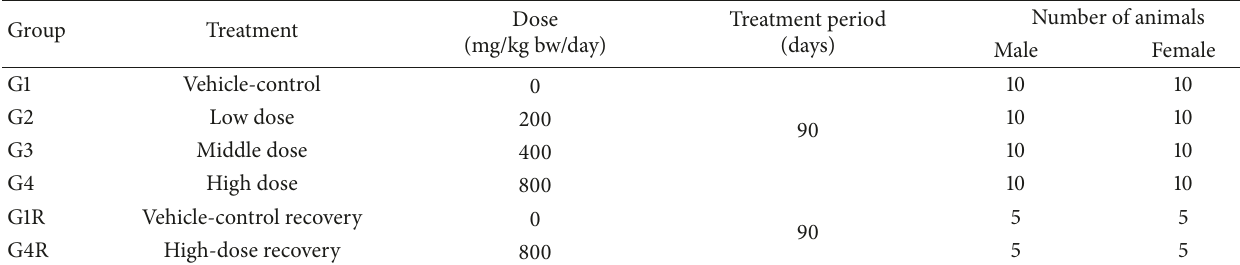
Table 2: 90-day study dose